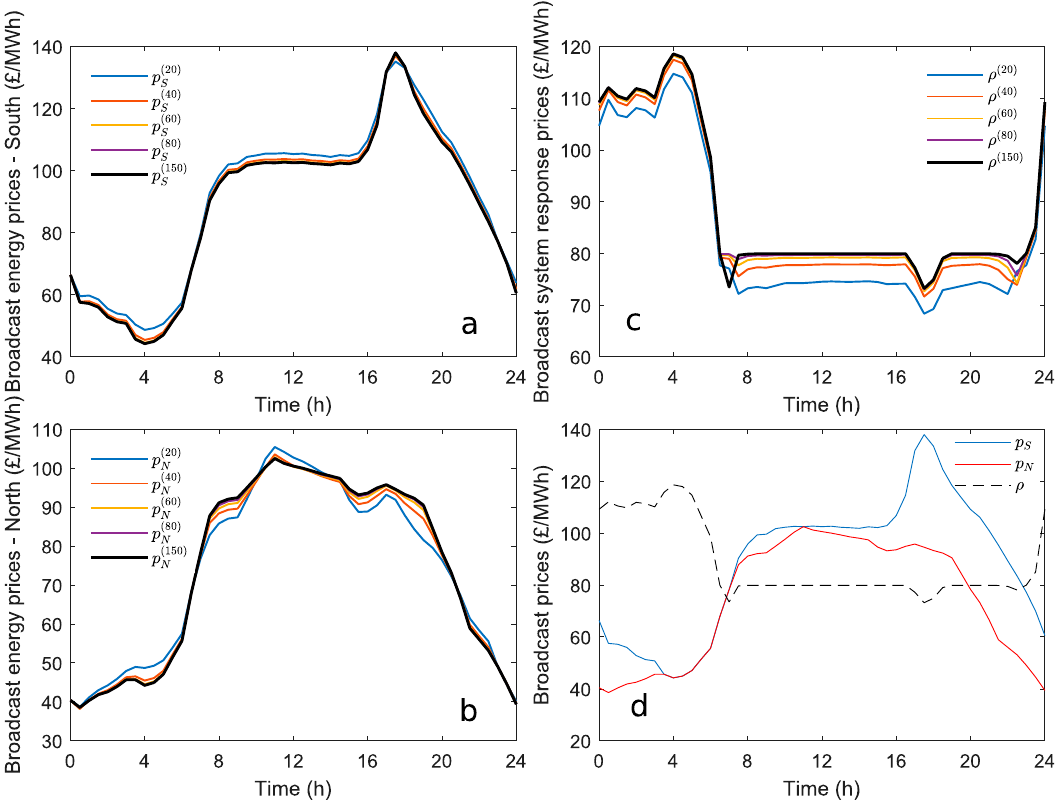
Figure 6. ( a ) Energy prices 𝑝 (cid:3020) (𝑡) in the SA at different iterations of the DCS. ( a , b ) Energy prices 𝑝 (cid:3015) (𝑡) in the NA at different iterations of the DCS. ( c ) System-level FR prices 𝜌(𝑡) at different iterations of the DCS. ( d ) 𝑝 (cid:3020) (𝑡),𝑝 (cid:3015) (𝑡) , and 𝜌(𝑡) at the equilibrium